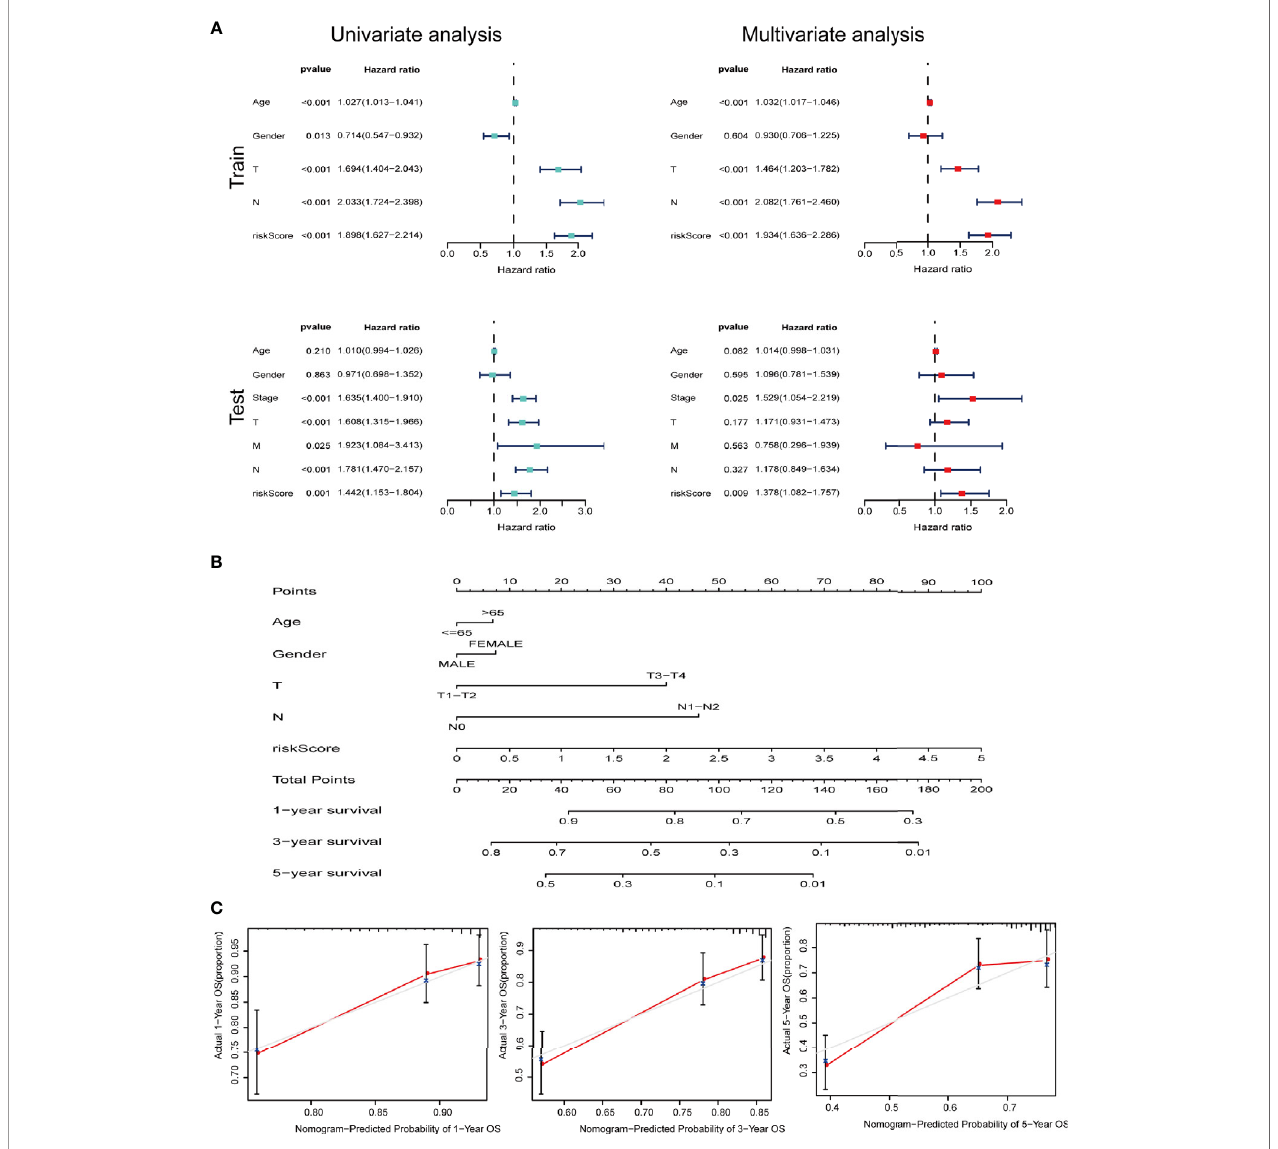
FIGURE 6 | IRGs and CCRGs combined with other clinical factors to predict prognosis of LUAD patients based on OS model. (A) Univariate and multivariate Cox regression revealed signi fi cant survival-related clinicopathological parameters in forest plots diagram. (B) Nomogram and (C) calibration curve was constructed to verify the accuracy of predicting 1-, 3-, and 5-year survival